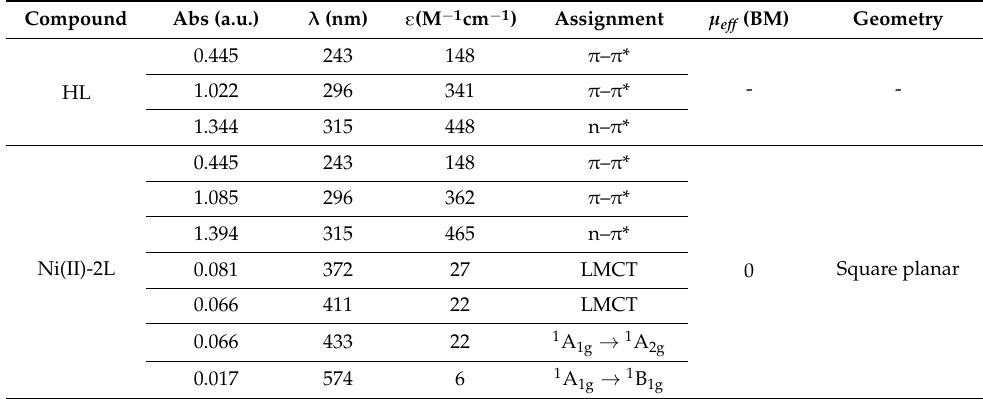
Figure 5. Electronic spectra of the N ′ -(4-methoxybenzylidene)benzohydrazide (HL) ligand and its nickel(II) complex (Ni(II)-2L). The inset is a magnification view in the range of 350–700 nm. Table 4. Electronic transitions and magnetic moment data of N ′ -(4-methoxybenzylidene)benzohydrazide (HL) ligand and its nickel(II) complex (Ni(II)-2L). Compound Abs (a.u.)